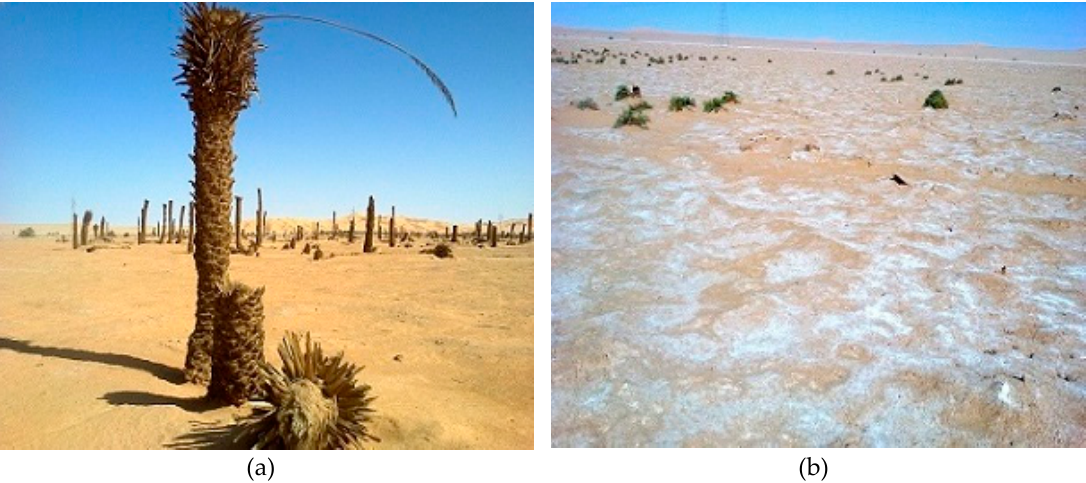
Figure 13. ( a ) Desertification in Al Fajij, Fezzan, and ( b ) salinization in Toyoh, Fezzan (photos courtesy: Abdalla Adda). Table 16. The aridity zones of Libya per area [59].